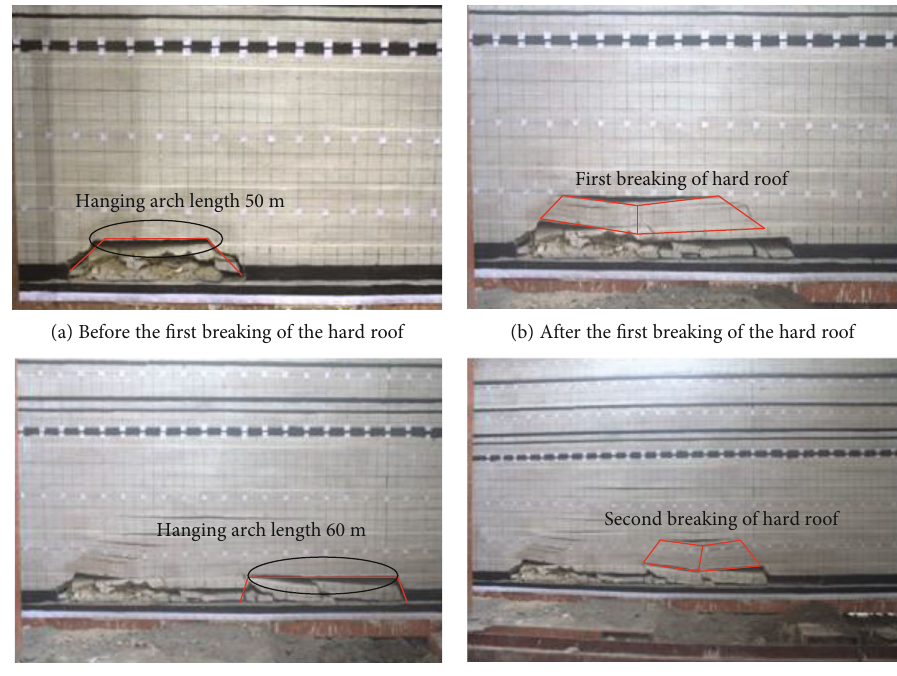
Figure 8: Before and after the breaking of a hard